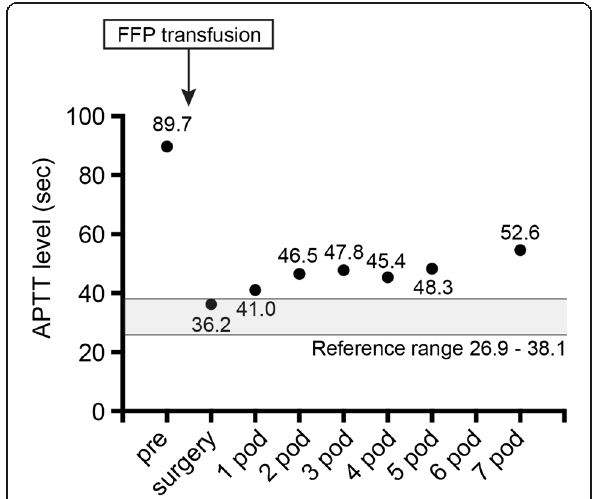
Fig. 1 Perioperative activated partial thromboplastin time (APTT) levels. FFP fresh frozen plasma, POD postoperative